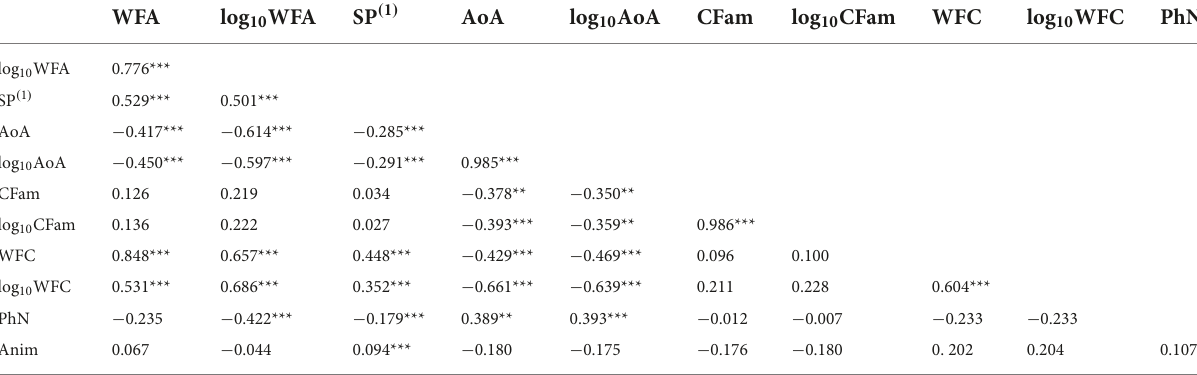
TABLE 3 Pairwise correlations between the word descriptors considered in Experiment 2.